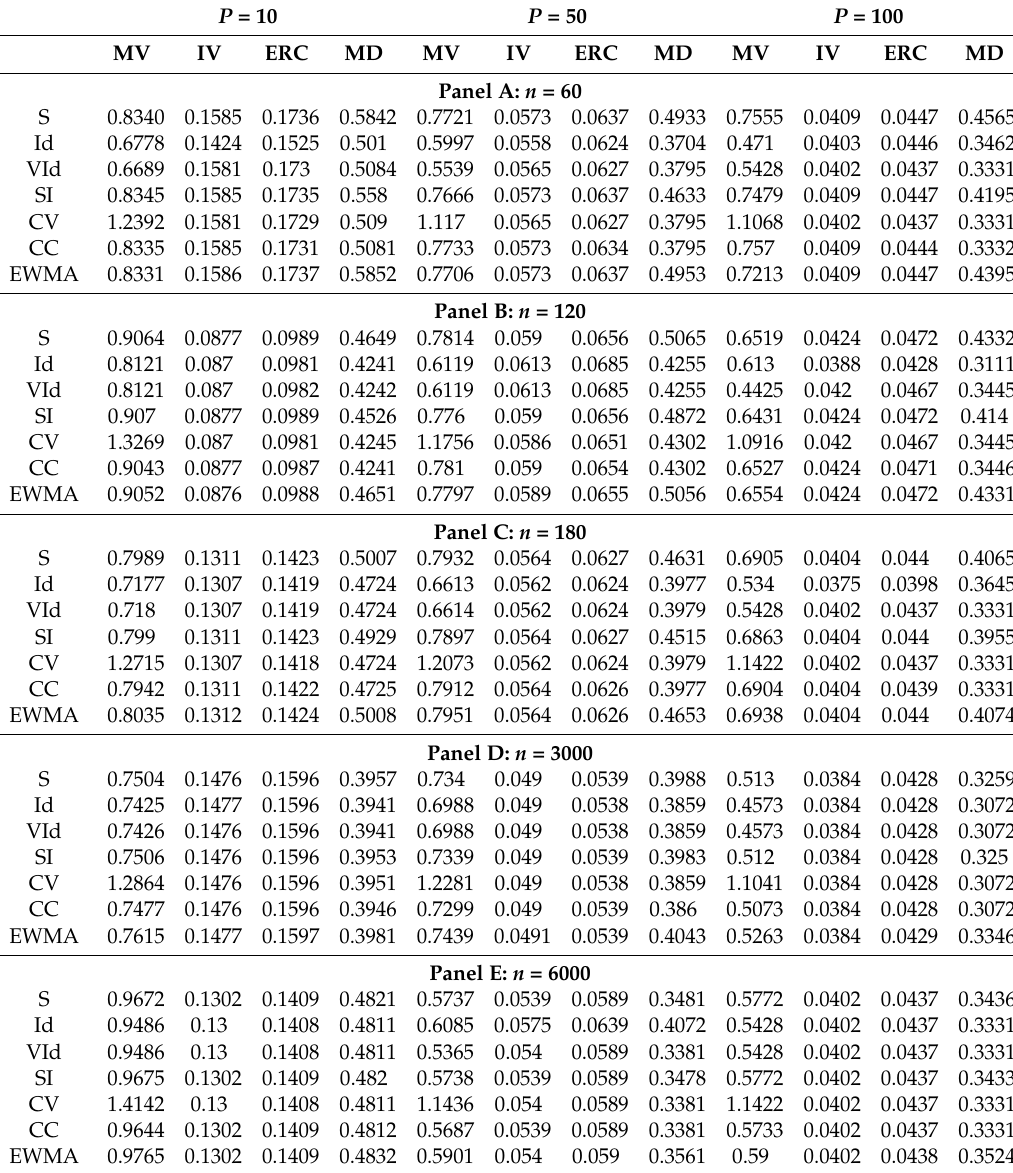
Table 4. Frobenius norm for the portfolio weights. Values corresponds to the optimal shrinkage intensity, listed after the Frobenius norm for each portfolio. We report values for the sample covariance matrix ( δ = 0) separately in the first row of each panel. For each n , the first line reports the Frobenius norm for the sample covariance matrix. Abbreviations used are: S for sample covariance; Id for identity matrix; VId for Variance Identity; SI for Single-Index; CV for Common Covariance; CC for Constant Correlation and EWMA for Exponentially Weighted Moving